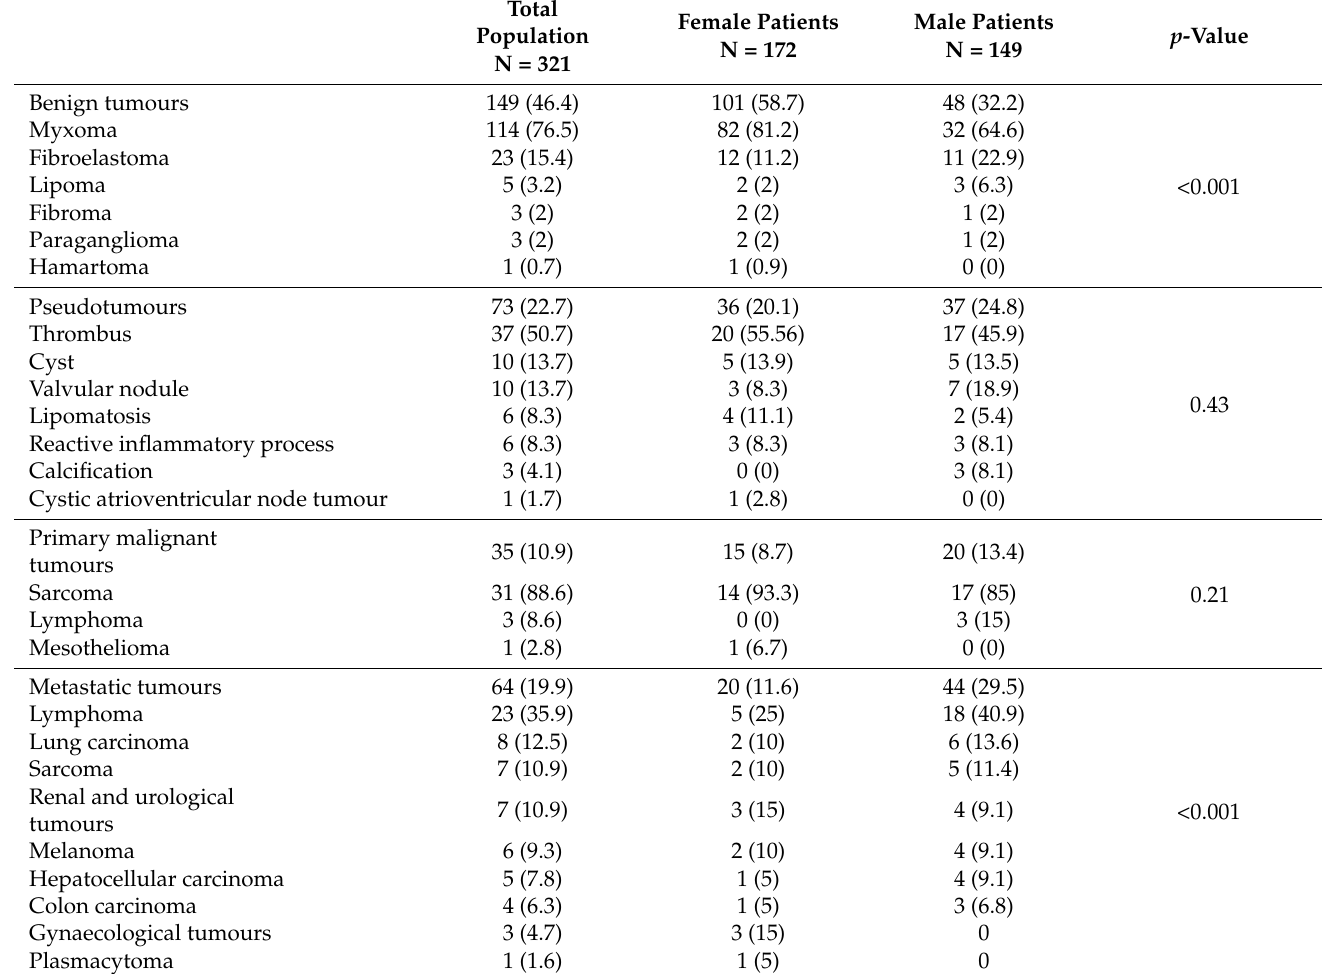
Table 3. Histological characterization of cardiac neoformations according to female and male patients.